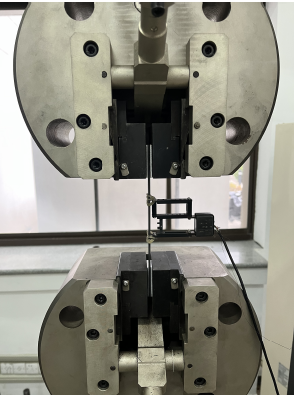
Figure 11. Experimental fixture and displacement